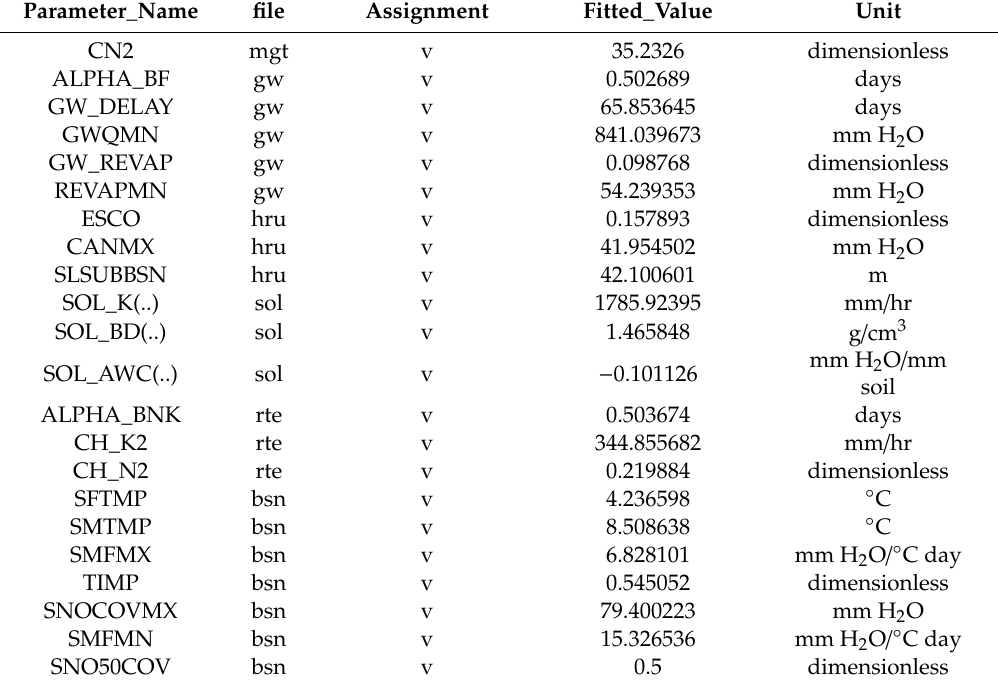
Table 4. Parameter calibration results.